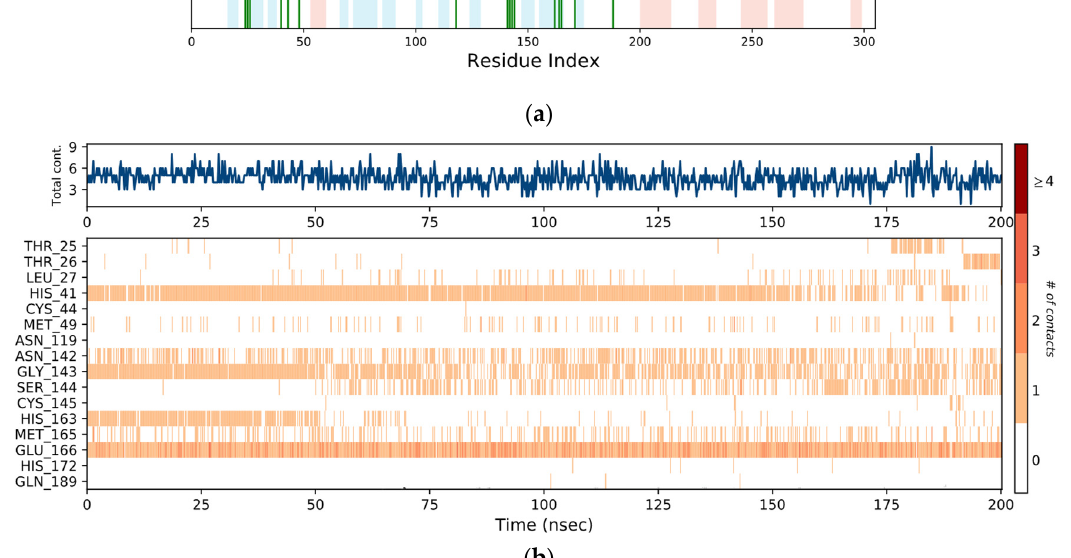
Figure 3. ( a ) 6WCO Molecular dynamic root-mean-square deviation (RMSD) and root-mean-square fluctuation (RMSF) plots. For the RMSF plot: ligand contacts are reported in green; orange zones represent α -helices, blue zones refer to β -sheets and white to not folded regions of the protein. ( b ) Protein–ligand contact timeline. Dark orange shades correspond to higher number of contacts.